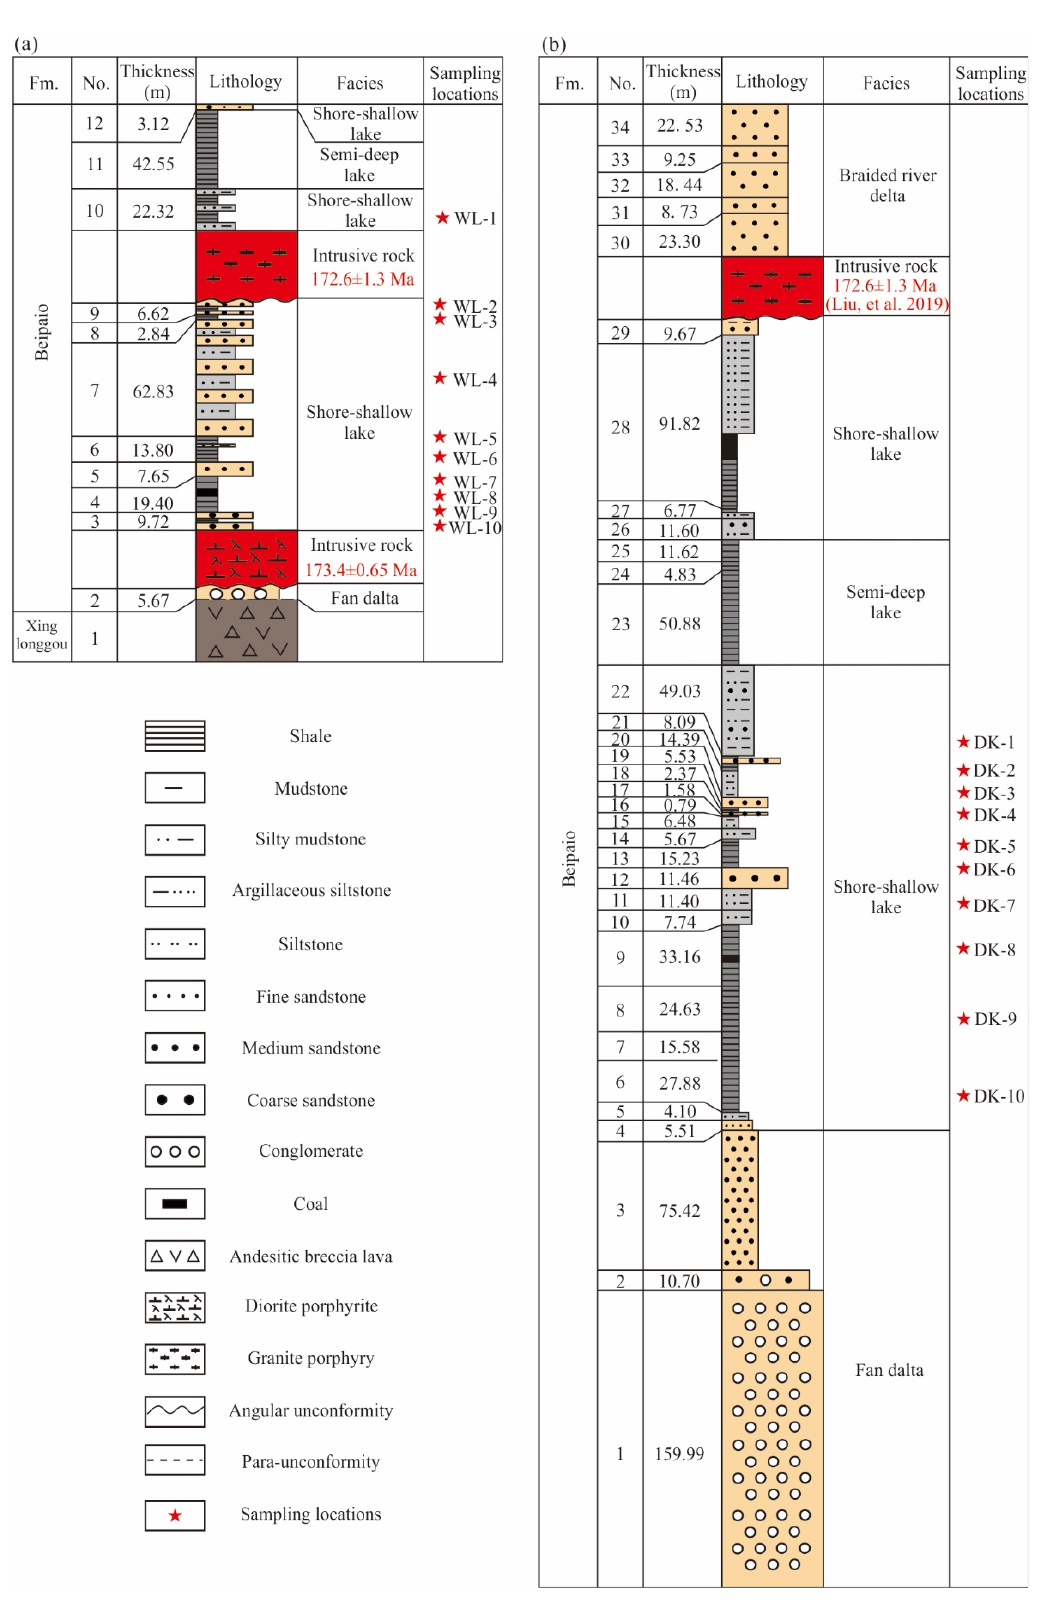
Figure 2. ( a ) Column of the Beipiao Formation in the Wolong outcrop, ( b ) Column of the Beipiao Formation in the Dongkuntouyingzi outcrop. Formation in the Dongkuntouyingzi